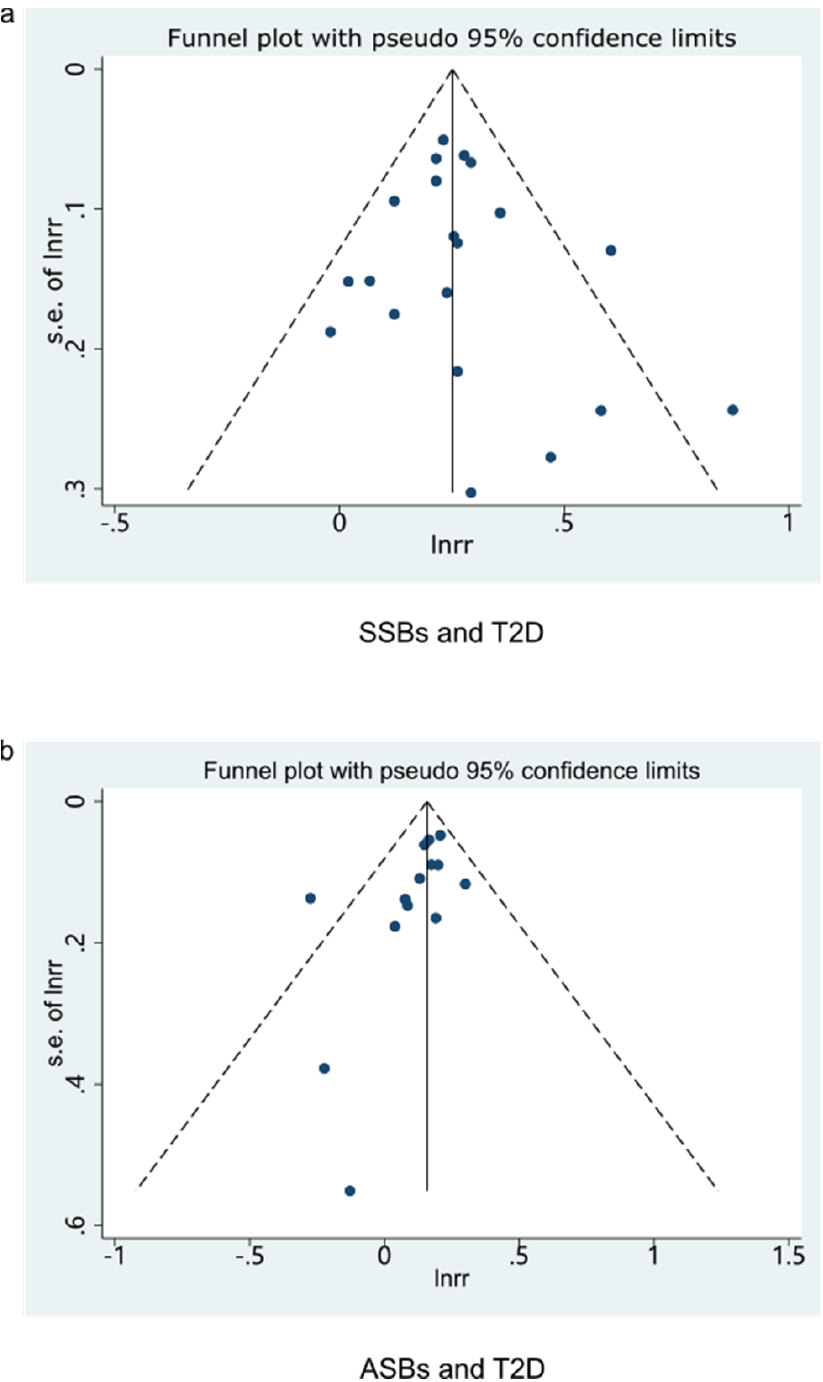
Figure 3. Funnel plot for examination of publication bias of studies (highest/lowest). ( a ) Funnel plot for SSBs and T2D. ( b ) Funnel plot for ASBs and T2D. SSBs, sugar-sweetened beverages; ASBs, artificially sweetened beverages; T2D, type 2